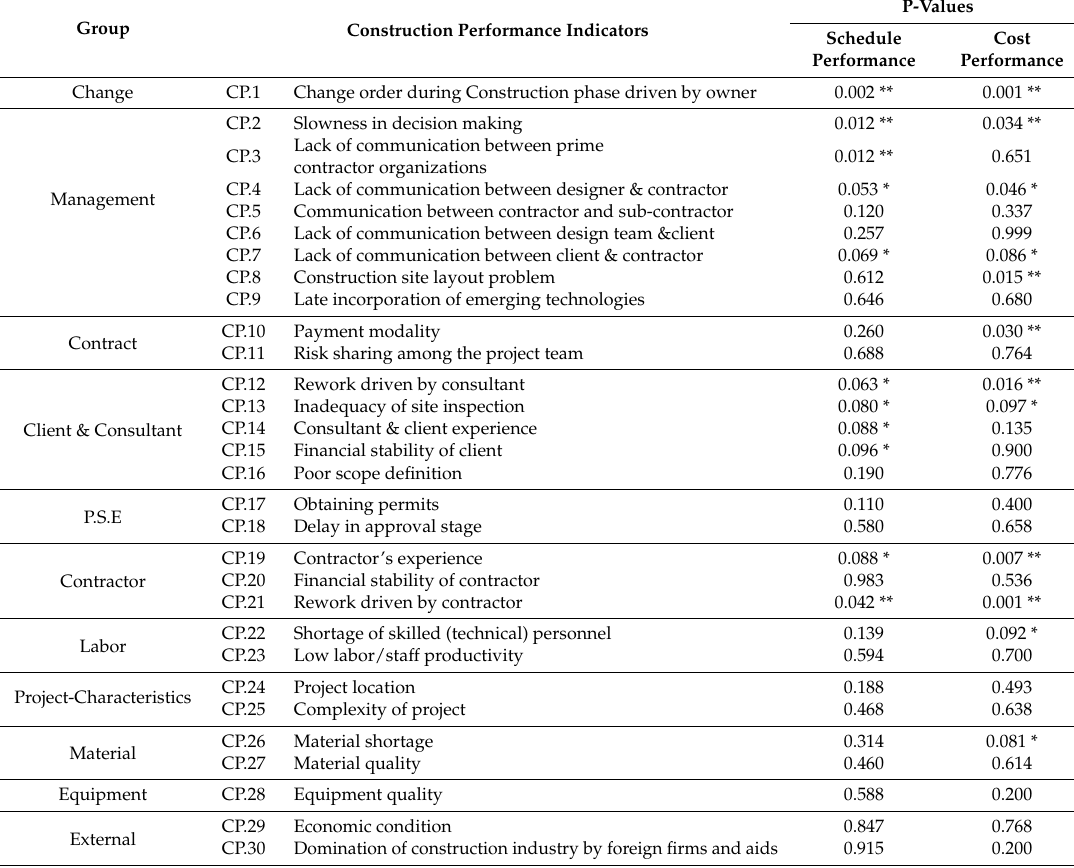
Table 5. Construction Phase Cost and Schedule Performance